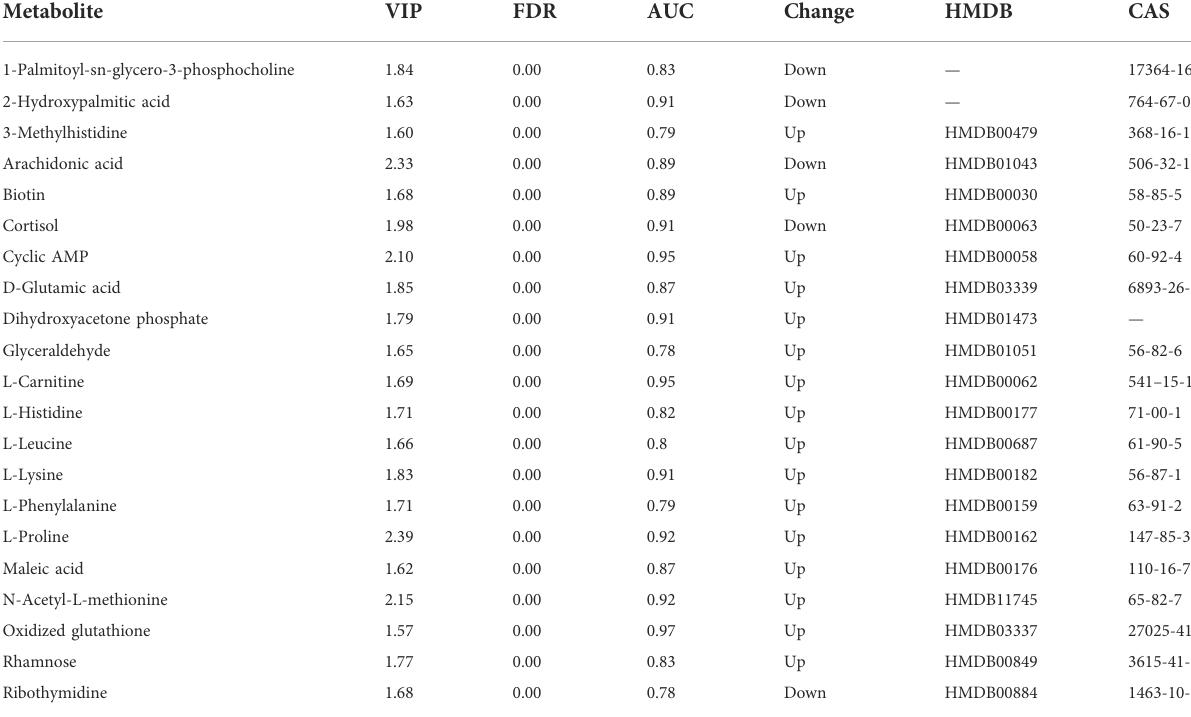
TABLE 2 The signi fi cantly different metabolites of pSS and HCs.